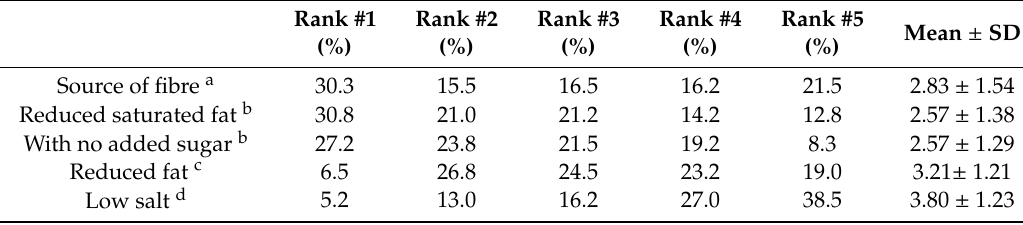
Table 3. Probability of ranks and ranking means: Biscuits.